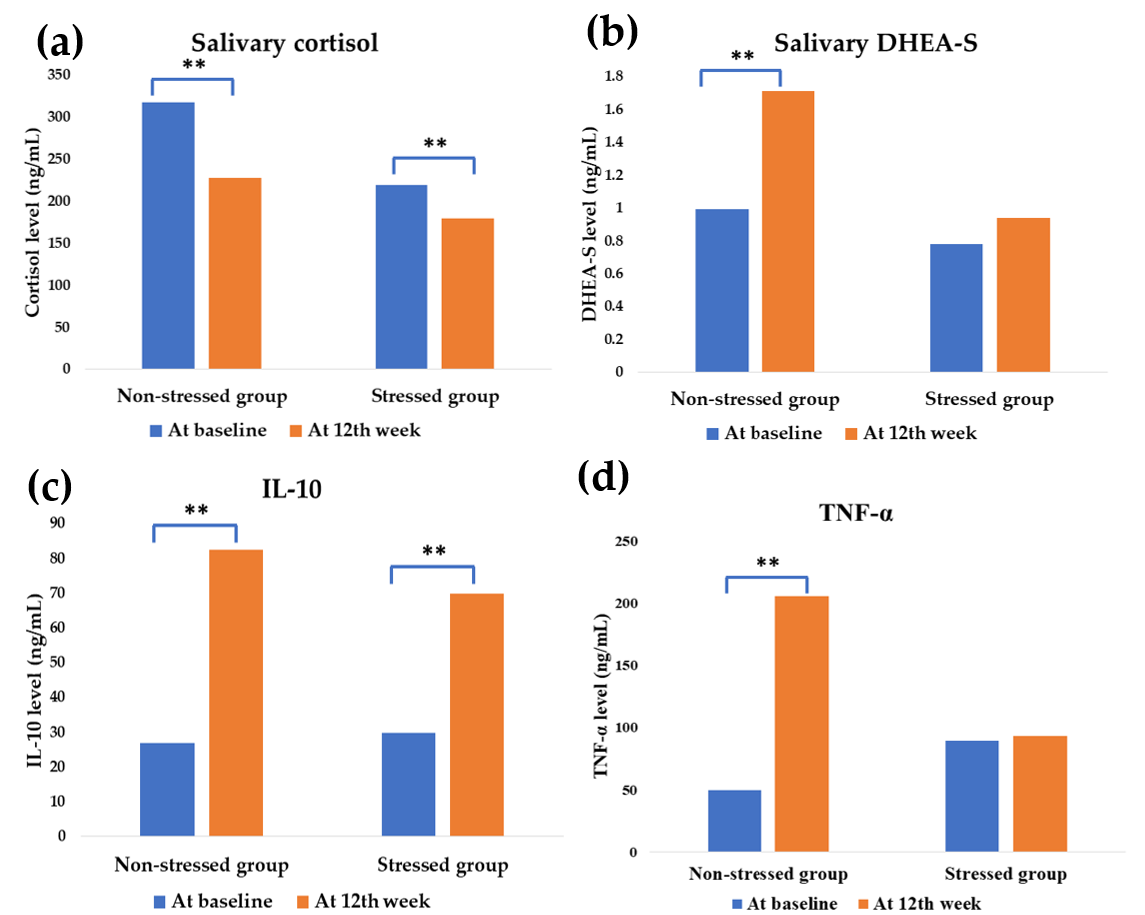
Figure 4. Effect of synbiotics administration on HPA-axis and neuro-inflammatory cytokines mod- ulation. The blue and orange bar shows the values at baseline and the 12th week of synbiotics administration, respectively. ** significant difference ( p less than 0.05). DHEA-S = Dehydroepiandros- terone sulfate; IL-10 = Interleukin-10; TNF- α = Tumor Necrosis Factor-alpha. The effect on HPA-axis: ( a ) Mean salivary cortisol value; stressed group: p = 0.033 (power = 0.65), non-stressed group: p = 0.015 (power = 0.96), ( b ) Mean DHEA-S value, non-stressed group: p = 0.012 (power = 0.99). The effect on inflammatory cytokines: ( c ) Mean IL-10 value; stressed group: p = 0.002 (power = 0.99), non-stressed group: p = 0.015 (power = 0.94), ( d ) Mean TNF- α value; non-stressed group: p = 0.002 (power = 0.99).